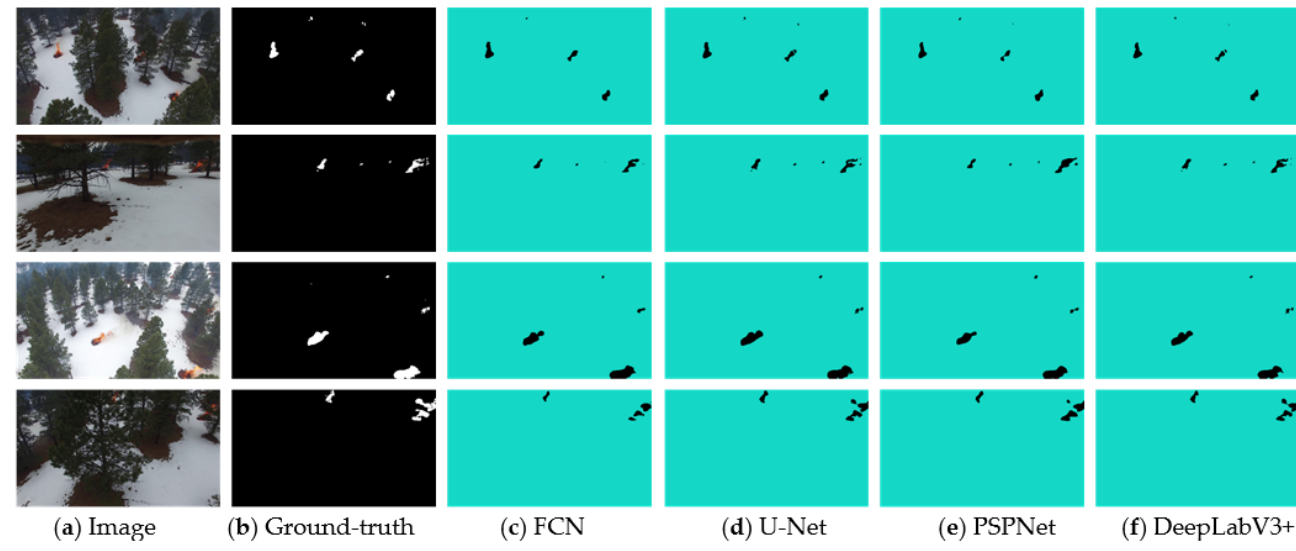
Figure 9. Results of forest fire image segmentation